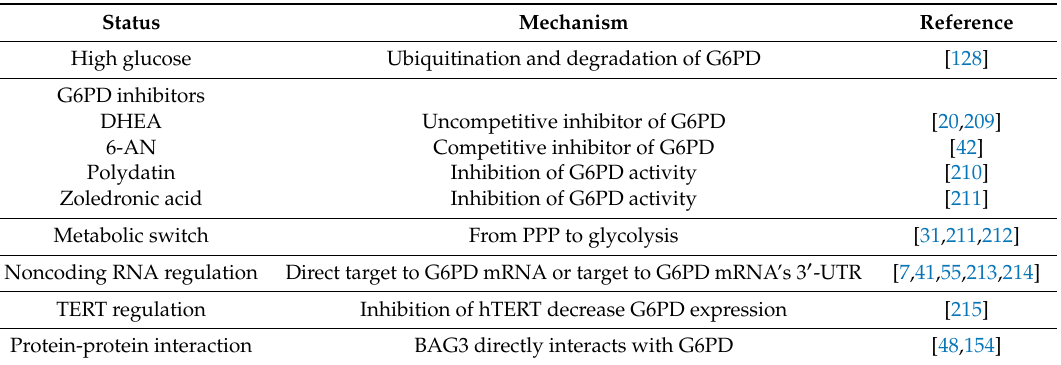
Table 3. Strategies of G6PD